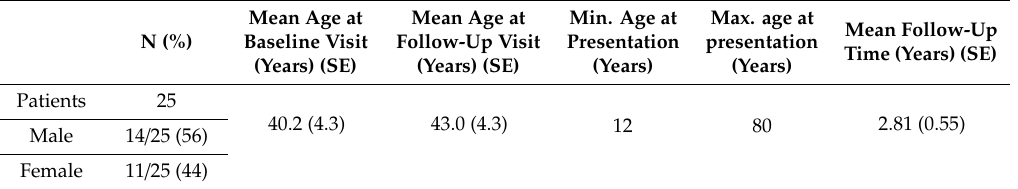
Table 2. Study subjects’ sex, mean age and standard deviation (SE), and follow-up times.